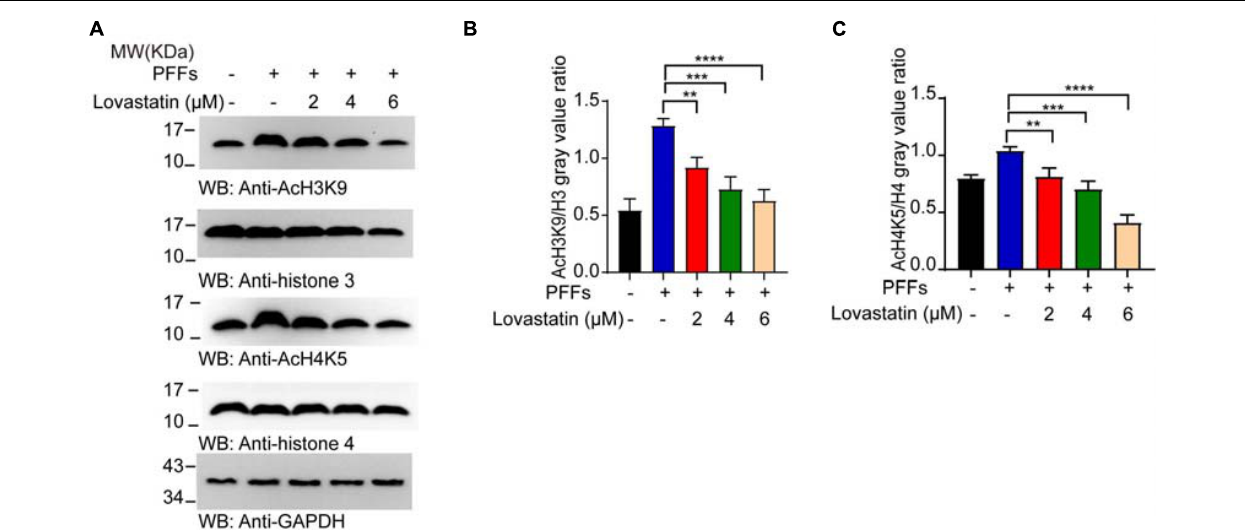
FIGURE 6 | Lovastatin mitigates the acetylation of the histone induced by PFFs. (A) Western blot detecting the content of AcH4K5, AcH3K9, Histone 3, and Histone 4. (B) Quantification of AcH3K9. Results are normalized to Histone 3. (C) Quantification of AcH4K5. Results are normalized to Histone 4. All data are means ± SEM, * P < 0.05, ** P < 0.01, *** P < 0.001, and **** P < 0.001, one-way ANOVA with Tukey’s multiple comparisons test. All experiments were performed in triplicate for at least three independent